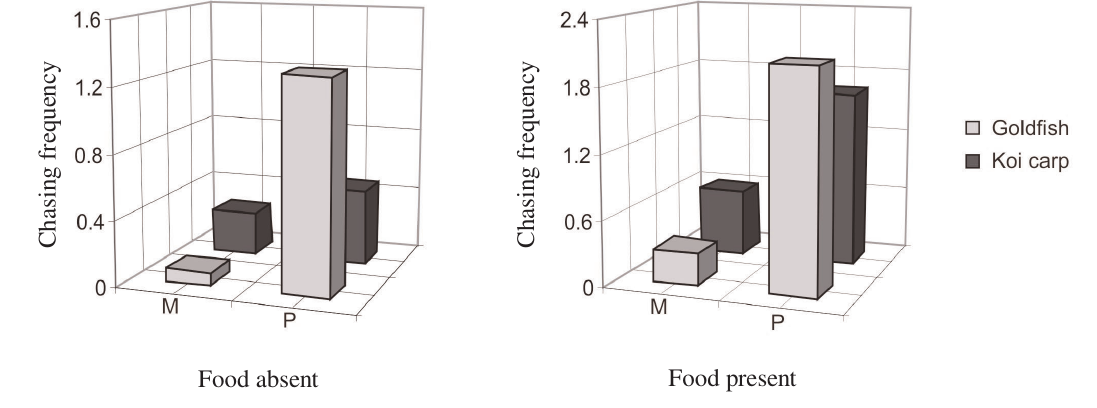
Food absent Fig. 1. Standardised (per capita) chasing frequency per trial estimated for koi carp and goldfish under monoculture (M) and poly- culture (P) conditions in aquaria in the presence and absence of food (tubifex)